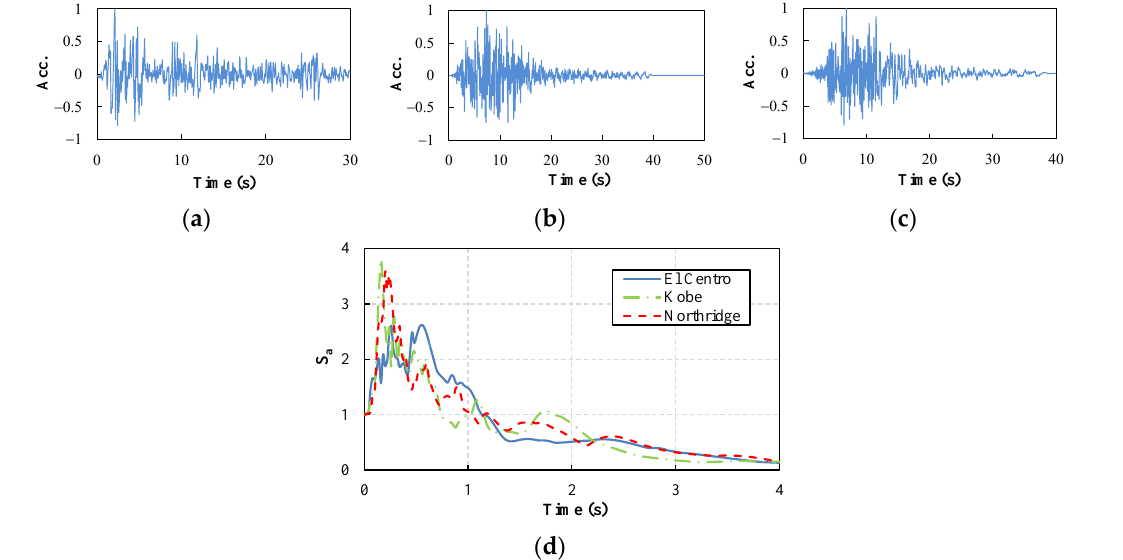
Figure 5. Earthquake acceleration (Acc.) time curve: ( a ) El Centro; ( b ) Kobe; ( c ) Northridge; and ( d ) S a under different ground motions.